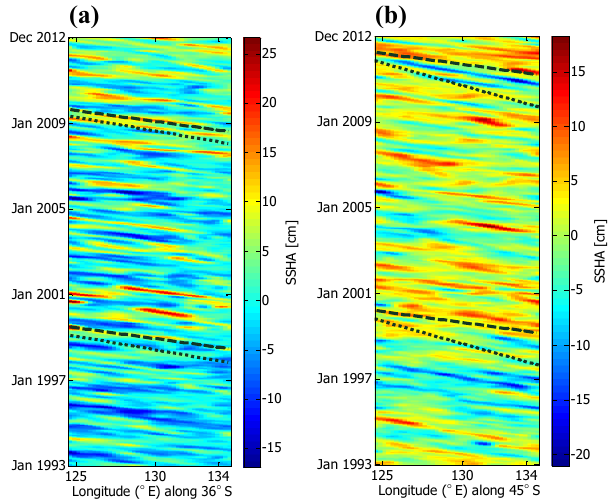
125 Longitude (  E) along 36  S Figure 3. Time–longitude (Hovmöller) diagrams at φ m = 36 ◦ S (a) and at φ m = 45 ◦ S (b) , where the abscissa is longitude and the or- dinate is the date. The temporal average was subtracted from the record of each grid point. Dashed lines: trapped wave phase speeds (Eq. 4); Dotted lines: harmonic wave phase speeds (Eq. 2).